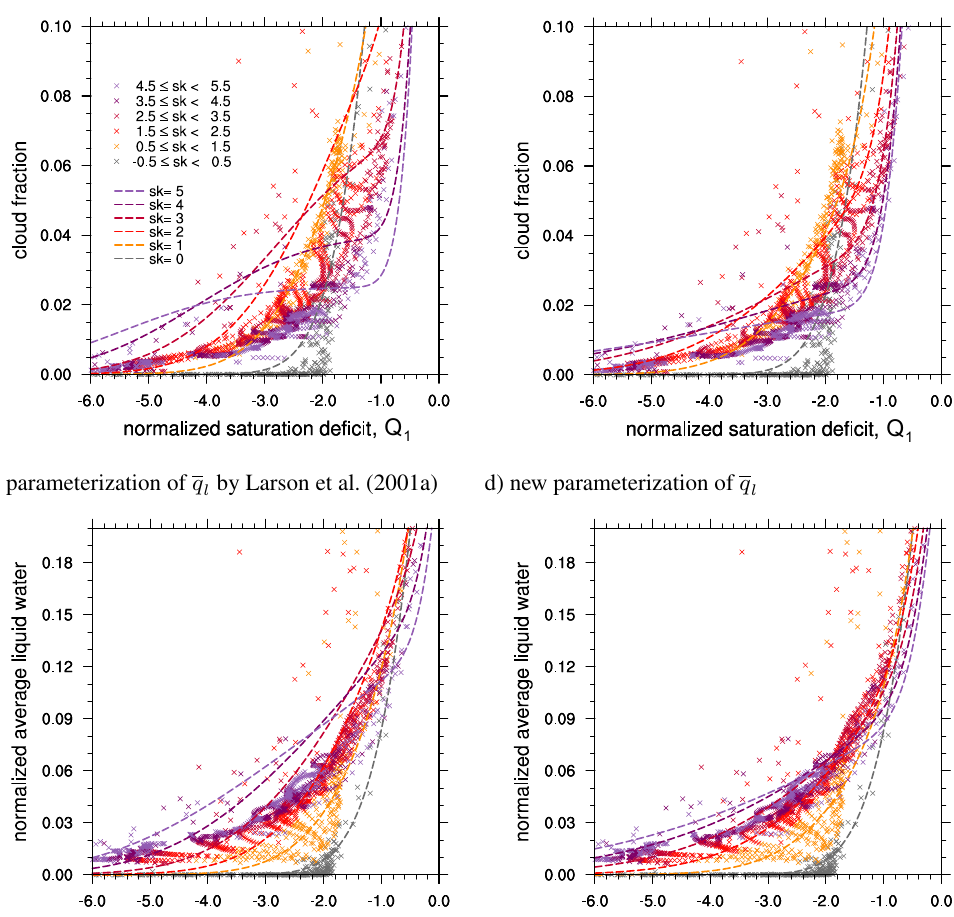
Fig. 6. The parameterizations (dashed lines) as a function of the normalized saturation deficit and the skewness shown together with the LES data of the ASTEX case (crosses).